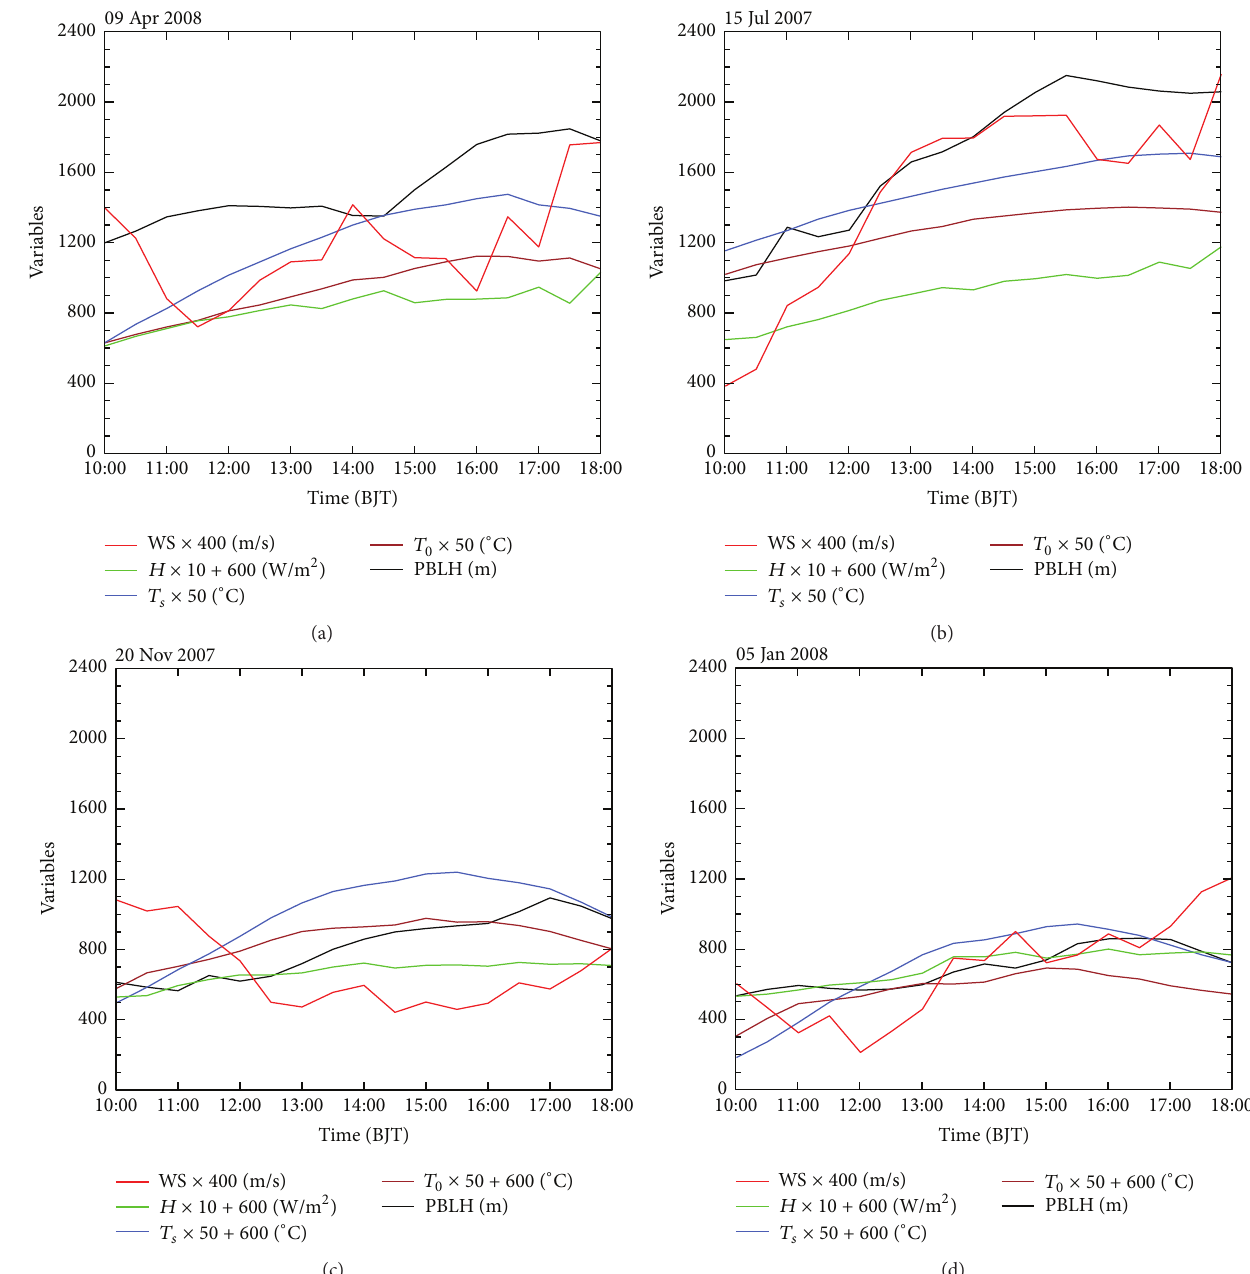
Figure 5: Temporal variations in boundary layer height (PBLH), sensible heat flux ( 𝐻 ), surface temperature ( 𝑇 𝑠 ), surface air temperature ( 𝑇 0 ), and surface wind speed (WS) on (a) 9 April 2008, (b) 15 July 2007, (c) 20 November 2007, and (d) 5 January